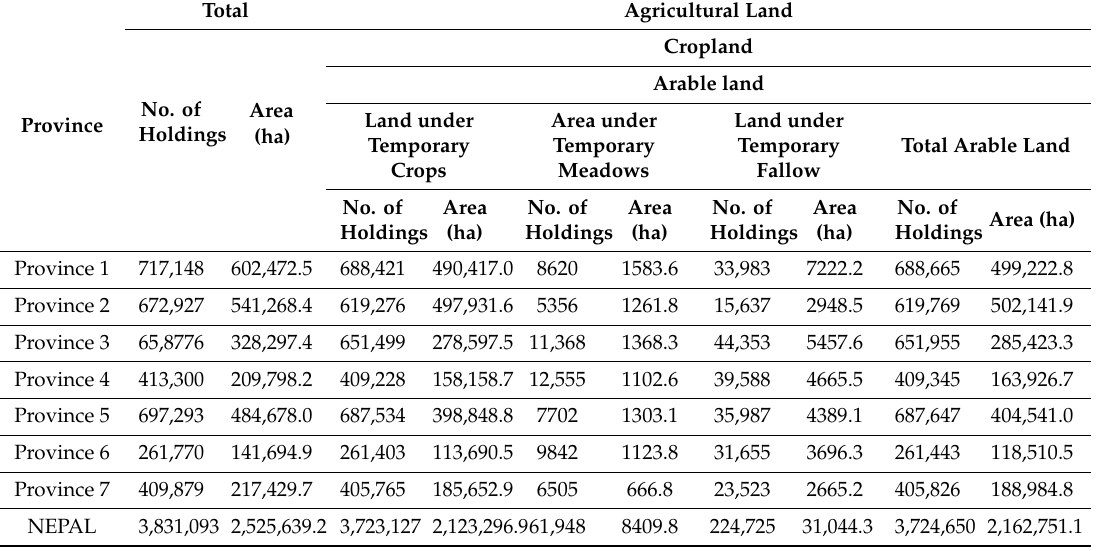
Table 2. Arable areas in various